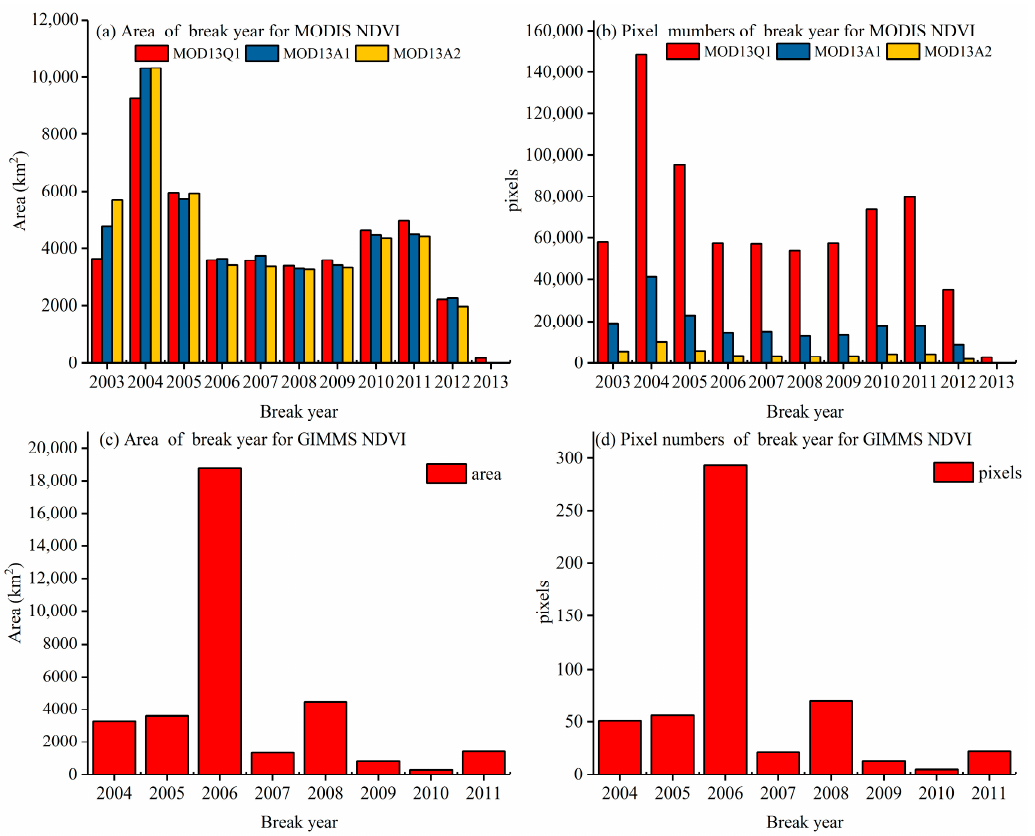
Figure 6. Comparison of the area and pixel numbers of the break years for MODIS NDVI and GIMMS NDVI in the PRD: ( a ) Area of the break year for MODIS NDVI in the PRD, ( b ) pixel numbers of the break year for MODIS NDVI, ( c ) Area of the break year for GIMMS NDVI in the PRD, ( d ) pixel numbers of the break year for GIMMS NDVI in the PRD.